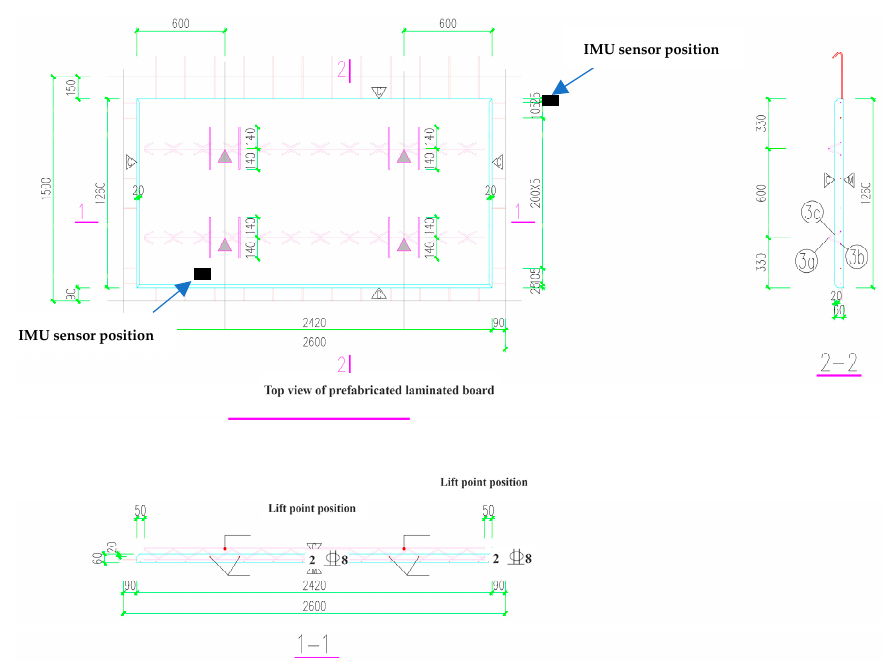
Figure 1. Research process diagram.